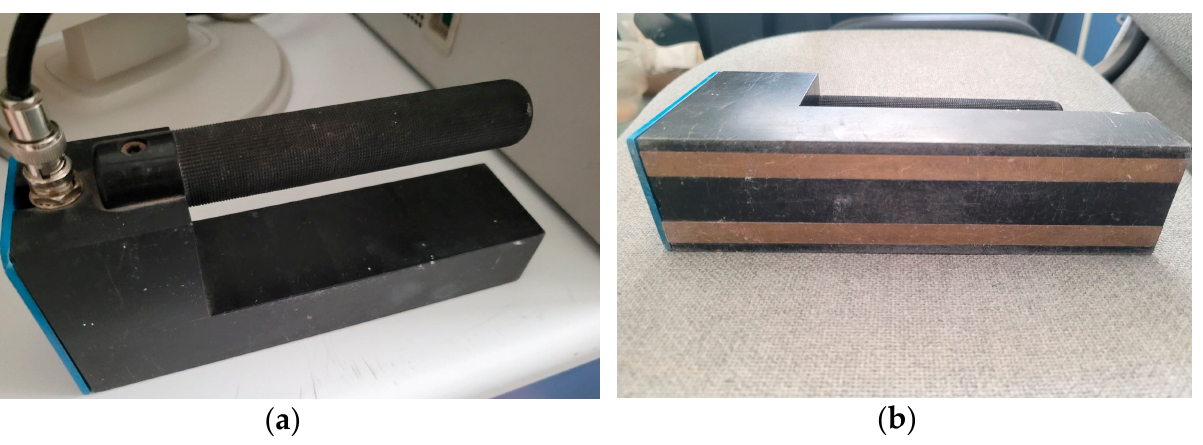
Figure 1. FP/mts TDR sensor applied in this research (ETest, Lublin, Poland).